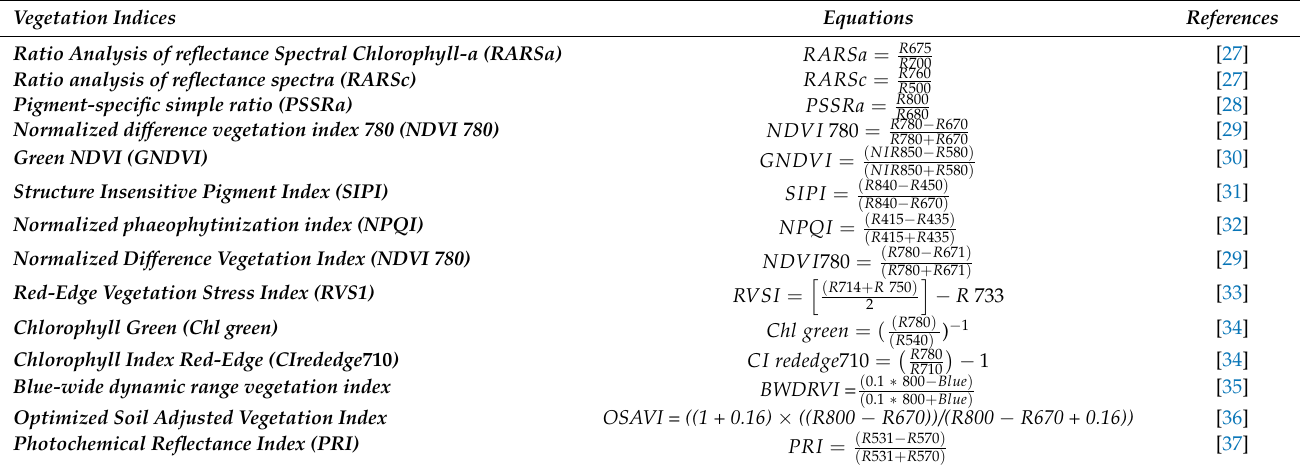
Table 1. Spectral vegetation indices, equation, and